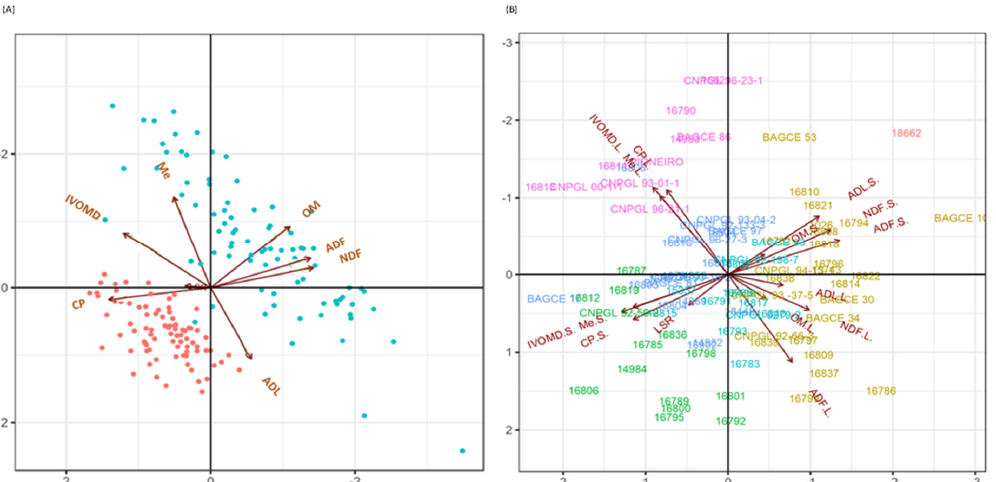
Figure 6. PCA biplots of seven feed quality traits and leaf-to-stem ratio for leaf and stem samples of Napier grass genotypes under the wet season: ( A ) Distribution of leaf (red dots) and stem (blue dots) tissue samples for feed quality traits; ( B ) Distribution of genotypes for feed quality traits in leaf and stem samples. The color of genotypes indicates different cluster groups. The angles between the vectors indicate positive and negative correlations among traits. Neutral detergent fiber (NDF); acid detergent fiber (ADF); acid detergent lignin (ADL); organic matter (OM); crude protein (CP); in vitro organic matter digestibility (IVOMD); metabolizable energy (ME). The suffixes L and S on the feed quality traits indicate leaf samples and stem samples,